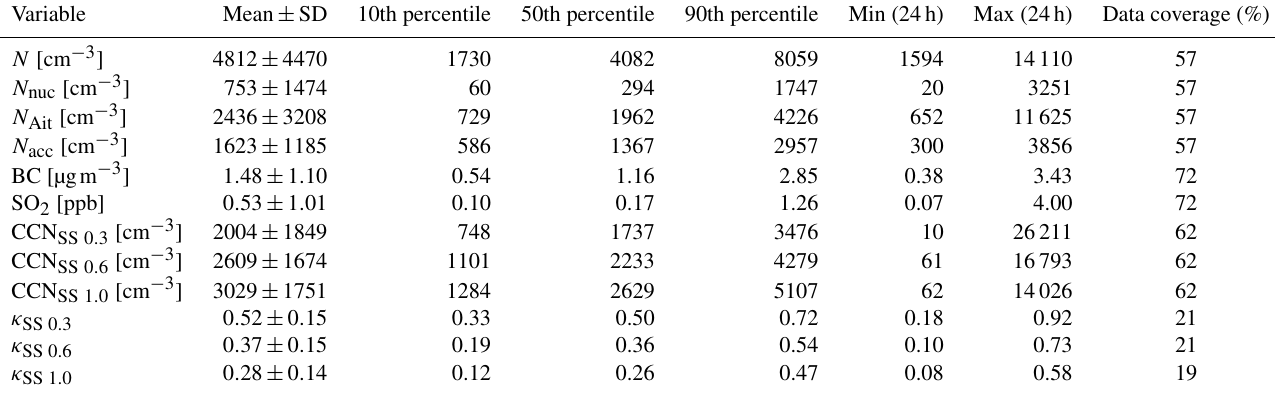
Table 2. Mean; standard deviation; 10th, 50th, and 90th percentile; minimum and maximum values of daily means; and data coverage for different measured variables. The size ranges for different aerosol particle modes are 10–25nm for nucleation mode aerosol particles, 25– 100nm for Aitken mode aerosol particles, and 100–800nm for accumulation mode aerosol particles. N is total number concentration of all particles measured with the DMPS. N nuc is the total number concentration of nucleation mode aerosol particles. N Ait is the total number concentration of Aitken mode aerosol particles. N acc is the total number concentration of accumulation mode aerosol particles. BC is black carbon. CCN SS 0 . 3 is the total number concentration of cloud condensation nuclei in supersaturation 0.3, CCN SS 0 . 6 in supersaturation 0.6,